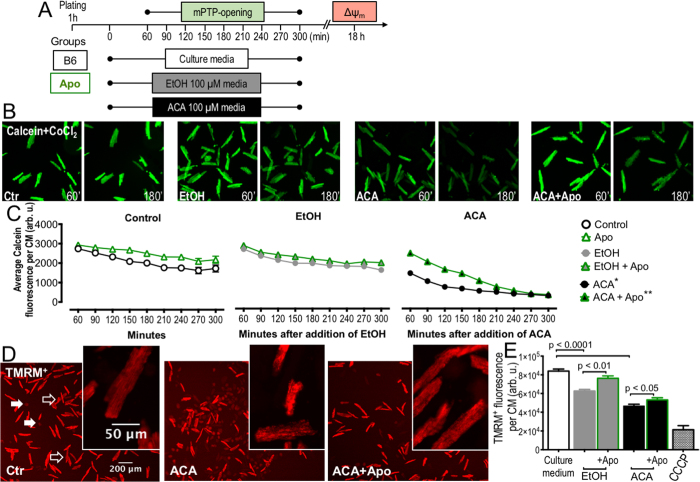
Inhibition of NOX prevents opening of the mitochondrial permeability transition pore (mPTP) and maintains mitochondrial polarization (ΔΨm) in isolated CMs exposed to EtOH/ACA.(A) Scheme depicting incubation and imaging of isolated adult CMs with EtOH (100 μM) or ACA (100 μM). (B) CM fluorescence after loading with calcein/CoCl2 and after incubation with EtOH or ACA and ACA+Apo, representative images. (C) Quantification of average calcein/CoCl2 derived fluorescence per CM, quantification Calcein/CoCl2 enhanced fluorescence of 100 CMs in 6–12 low power fields per group, *p < 0.01 vs Control, **p < 0.01 vs ACA. (D) CM fluorescence after loading with the voltage-sensitive fluorescent probe TMRM+ and after incubation with ACA and ACA+Apo, representative images. (E) Quantification of TMRM+-enhanced fluorescence of 416–887 CMs on 6–12 independent low power fields per group, black bar “+CCCP” depicts CM background fluorescence after mitochondrial depolarization with the ionophore/uncoupler carbonyl cyanide m-chlorophenyl hydrazone (CCCP) (Fig. S2). (C,E) Data presented as the mean ± SEM.